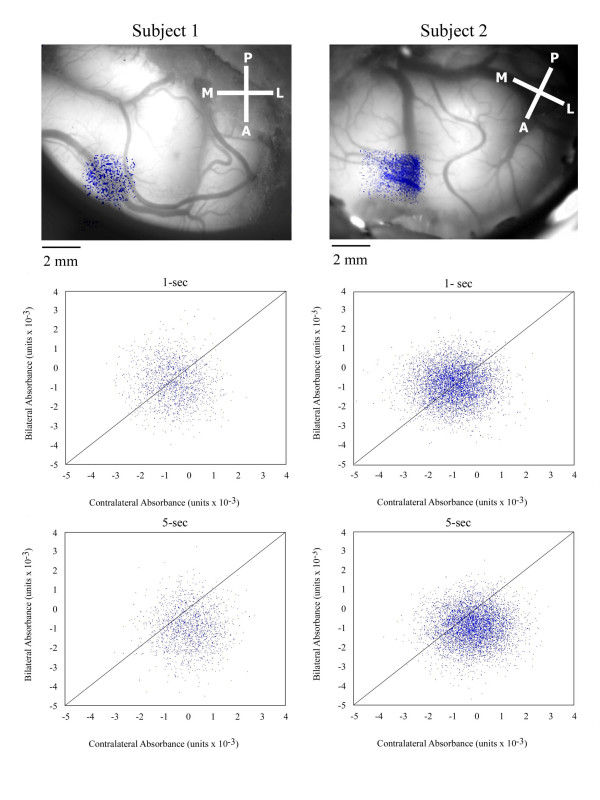
Scatter plots of contralateral vs. bilateral response of 2 subjects. For each plot, values of individual pixels are plotted as a function of the absorbance measured at that pixel evoked by the contralateral stimulus (horizontal axis) vs. the response measured at the same locus (or pixel) evoked by the bilateral stimulus (vertical axis). Top panel: cortical images taken with green filter, superimposed axes indicate anatomical orientation. Pixels superimposed on cortical image were selected using a threshold criteria (highest 5%) in response to both stimulus conditions and are represented by blue dots. Reference line, plotted at a slope of 1, indicates where pixels with equal values for both conditions lie.